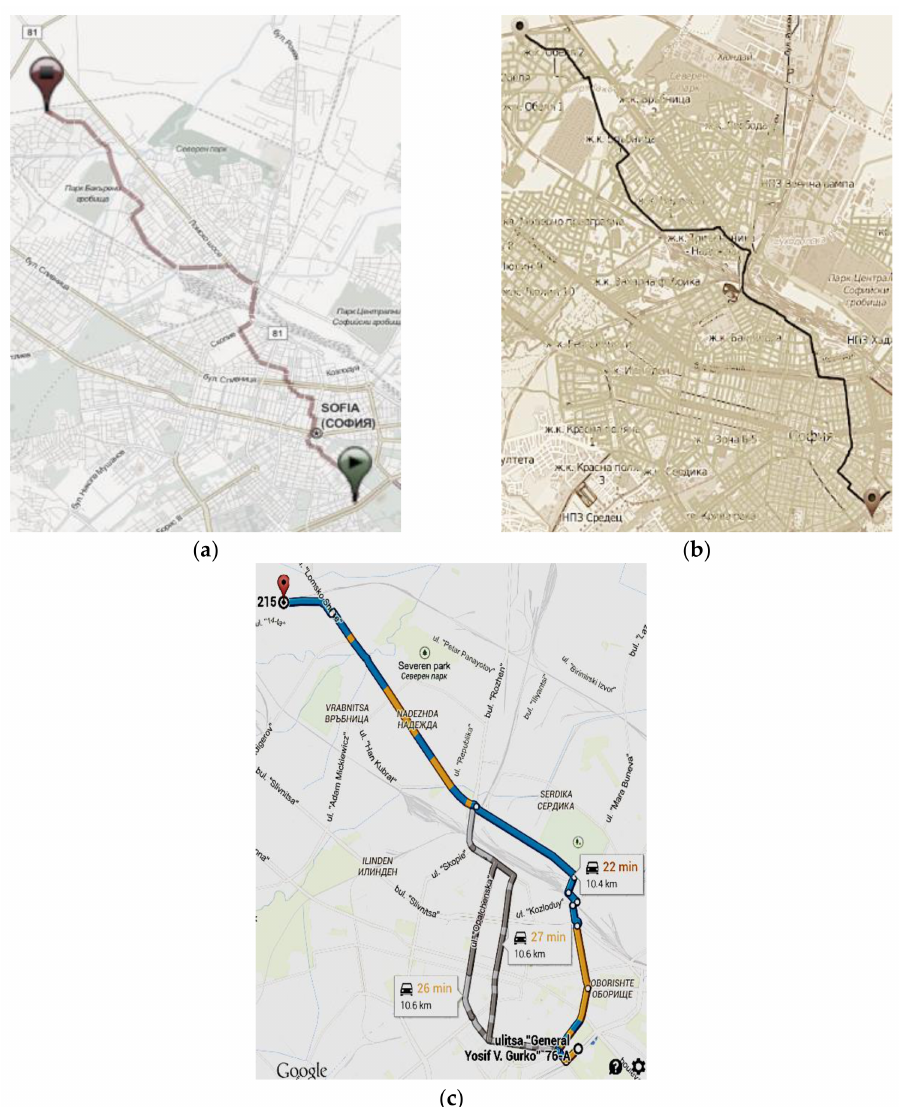
Figure 13. A comparative driving route calculation (in city of Sofia): ( a ) eco-friendly multimodal route guidance system (EMRG) user app; ( b ) traffic management web visualization; ( c ) Google Maps (clockwise